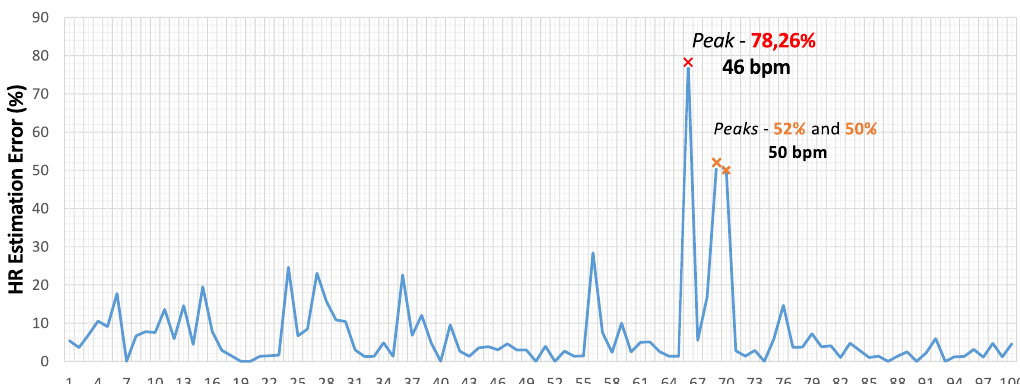
Figure 9. Average error (%) in HR estimation revealed by the Smartwatch (SW) with respect to Holter